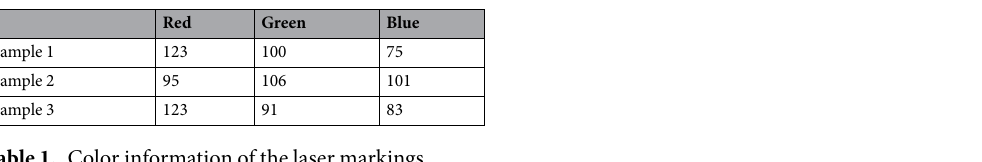
Table 1. Color information of the laser